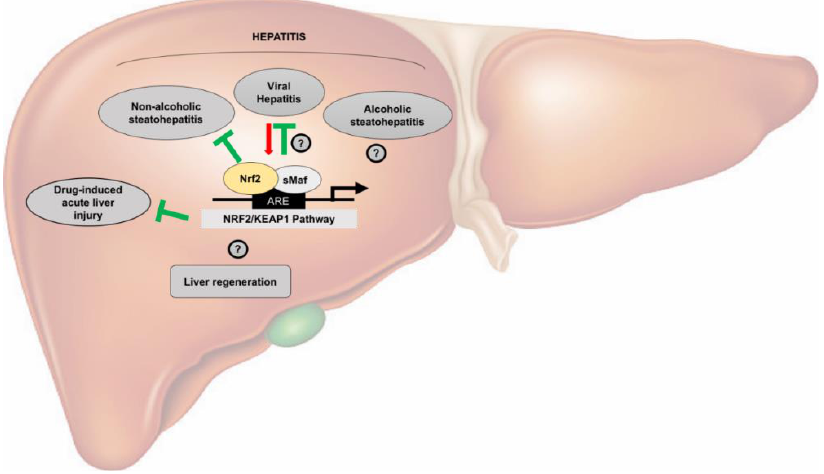
Figure 1. Nrf2 activation in non-neoplastic liver physiopathology. This scheme illustrates the role of the Keap1/Nrf2 pathway in non-neoplastic liver. For details see text. Green lines indicate inhibition; the red arrow indicates stimulation. Contradictory results are indicated by question marks.